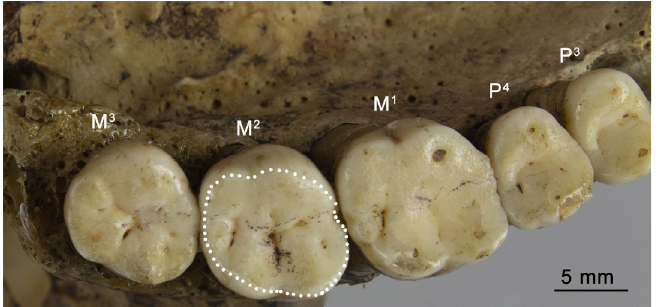
Figure 1. Occlusal view of permanent upper left teeth (P 3 , first premolar; P 4 , second premolar; M 1 , first molar; M 3 , third molar) with marked total occlusal area (TOCA) of the second molar (M 2 ) (specimen no. 20).